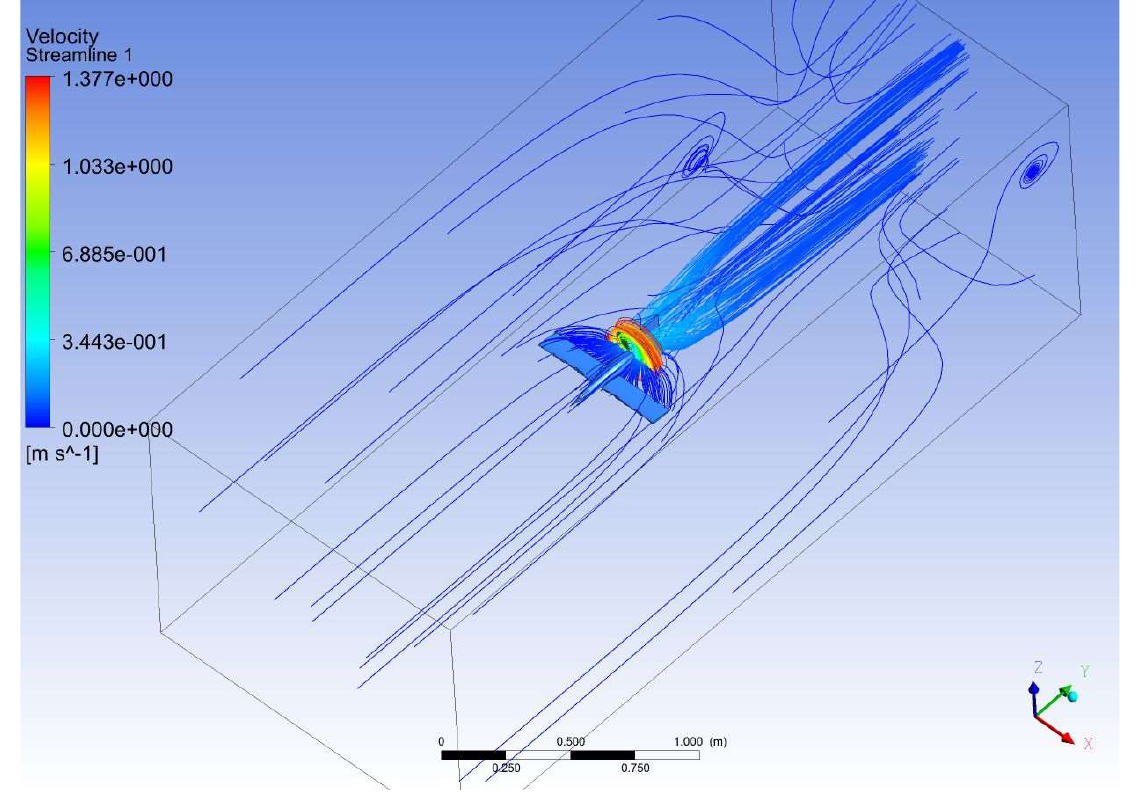
Aerospace 2022 , 9 , x FOR PEER REVIEW Figure 41. Aerodynamic velocity representations through streamline from inlet to outlet.